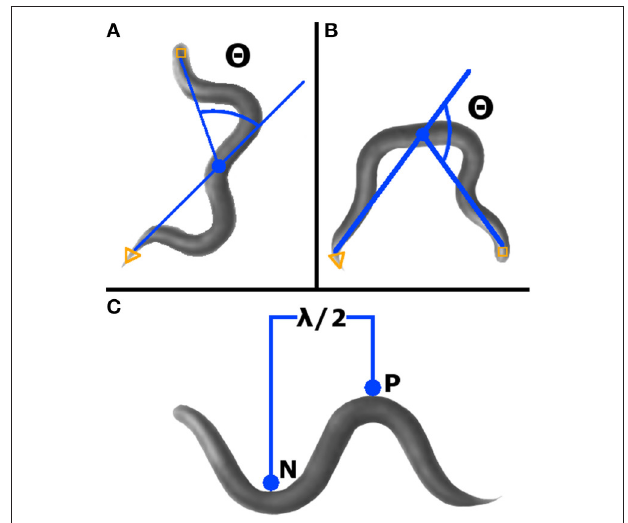
FIGURE 2 | WormLab advanced analyses. (A) Bending angle ( 2 ) was measured as the supplement of the angle between the head, mid-point, and tail. Worms with head, mid-point, and tail in line have an angle of zero. (B) Omega bending is indicated when the angle ( 2 ) created between the head, mid-point, and tail is < 90 ◦ (i.e., the bending angle is > 90 ◦ ). (C) Wavelength was measured as two times the distance between the positive (P) and negative (N) stationary